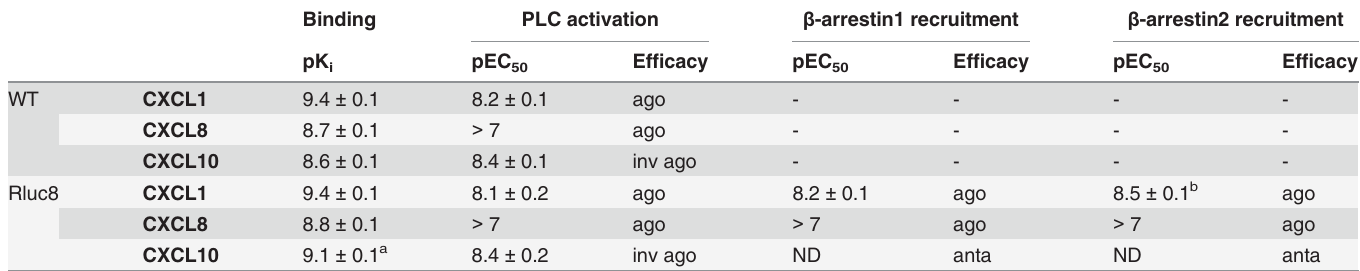
Table 1. Pharmacological characterization of ORF74-Rluc8.